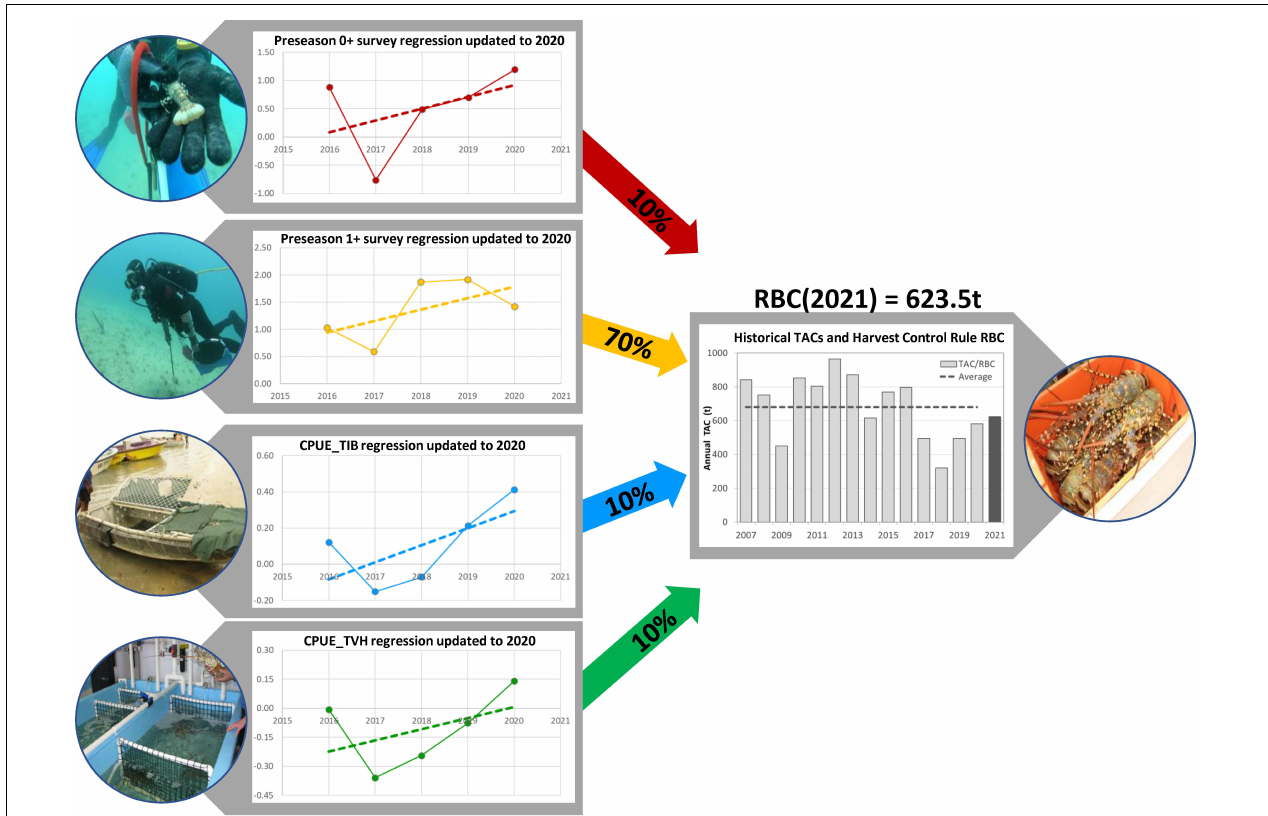
FIGURE 5 | Schematic summary of the empirical harvest control rule (eHCR) used to calculate the TRL (Tropical Rock Lobster) RBC (Recommended Biological Catch) based on the CPUE (Catch Per Unit Effort) data from two fishery sectors, the scientific survey indices of two age classes, and the total average catch over the past 5